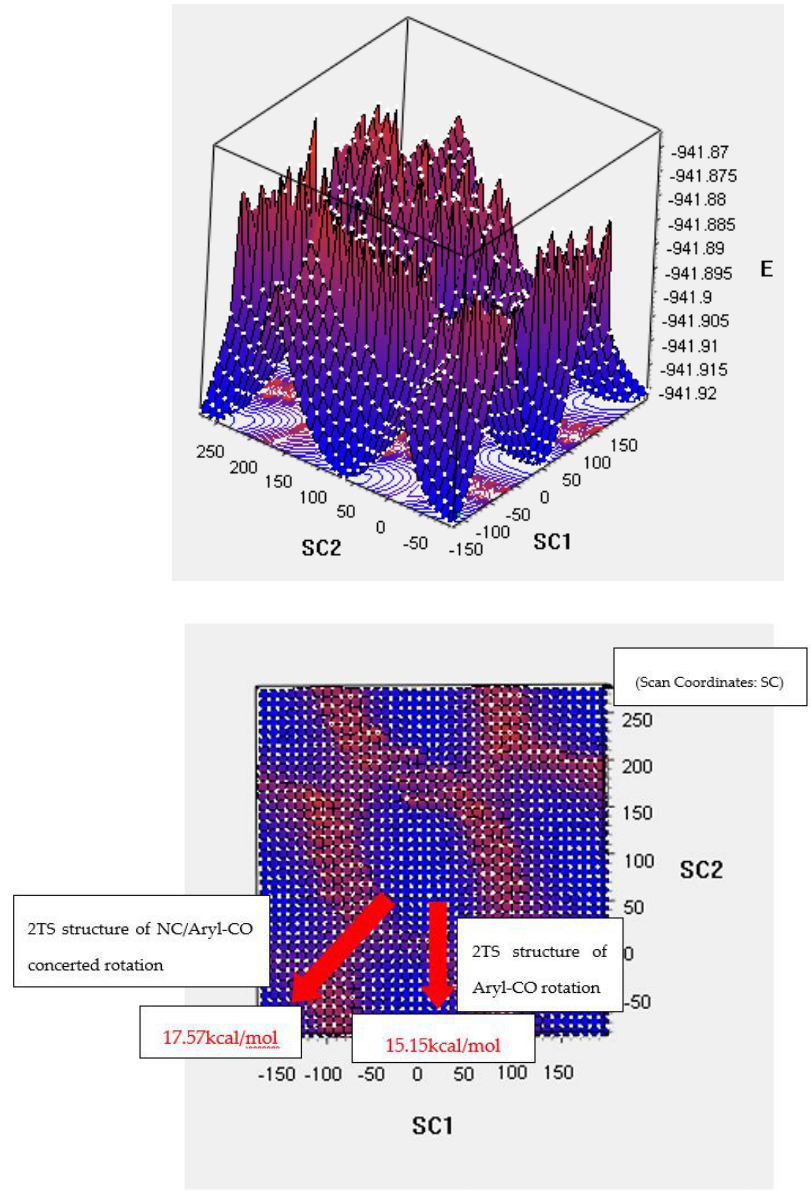
Figure 5. 2D-Potential Energy Surface on Aryl-C = O Dihedral angle and C-N Dihedral angle change of NCDEA ( a ) and PCDEA ( b ).